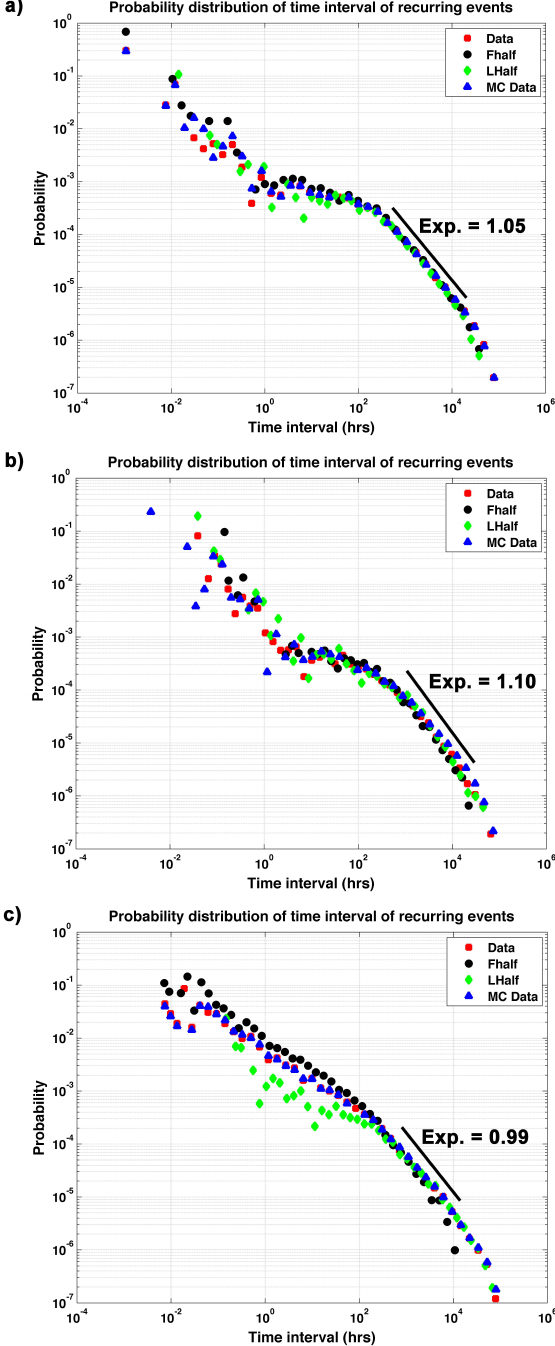
Fig. 7. Distribution of time-intervals between events and their re- currences for the full data sets, the recent half(Fhalf) and the early half (Lhalf) of the data sets for magnitude threshold of 2. For com- parison, we also show the MC1 results. (a) Region 1; (b) Region 2; (c) Region